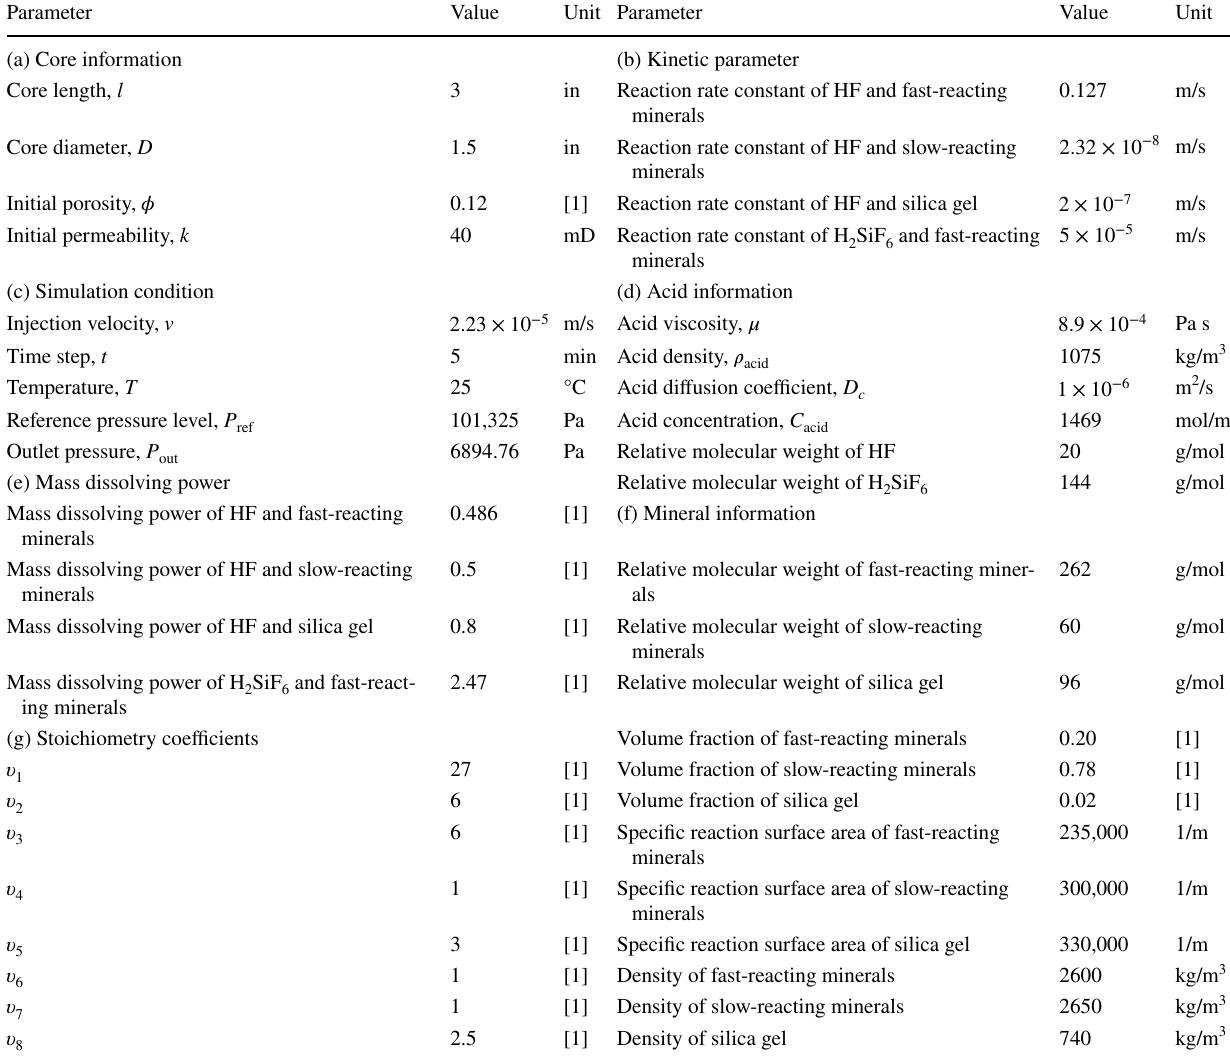
Table 1 Required input parameter in the model